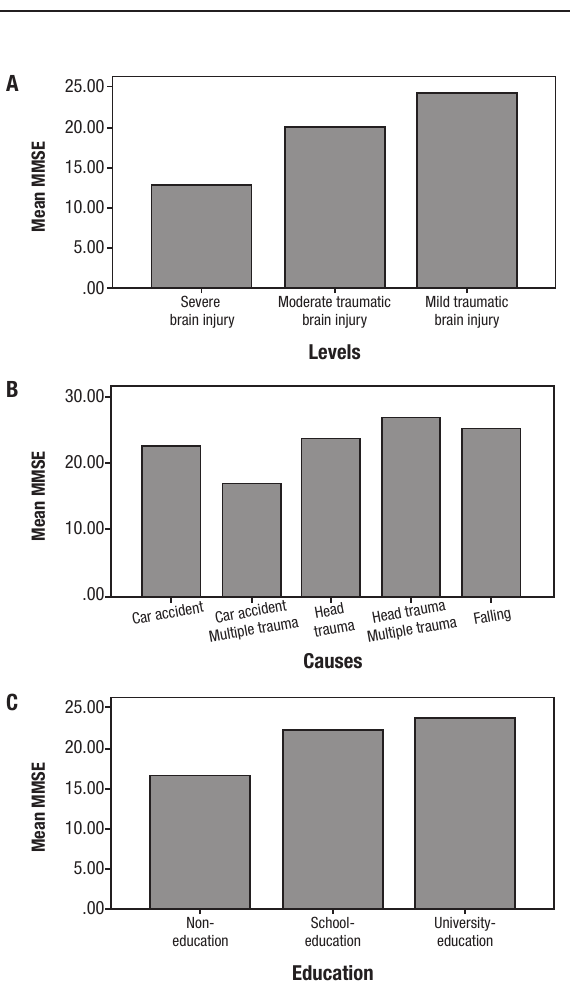
Figure 1. Cognitive impairment (MMSE) according to different levels and causes of TBI and education